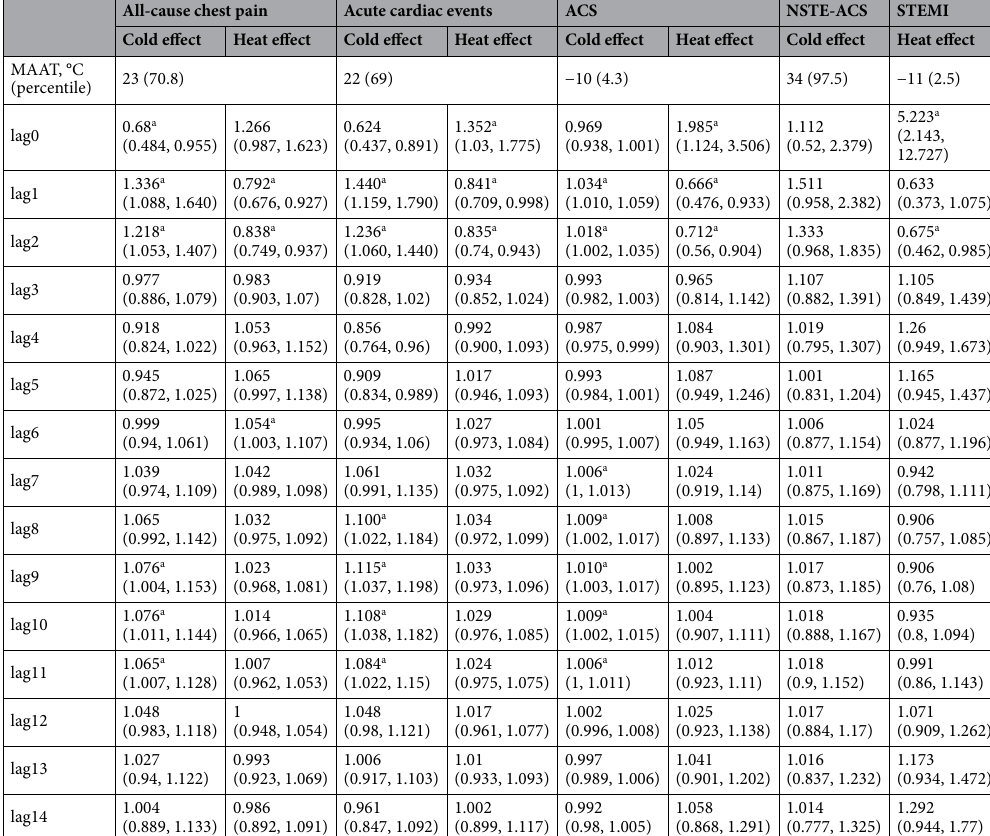
Table 3. The single day lag effects of extreme apparent temperature at different lag day(s) with the reference of the Minimum Admission Apparent Temperature (MAAT), by different chest pain categories. ACS, Acute coronary syndrome; STEMI, ST-segment-elevation myocardial infarction; NSTE-ACS, Non-STEMI acute coronary syndrome. a Relative risk values are statistically